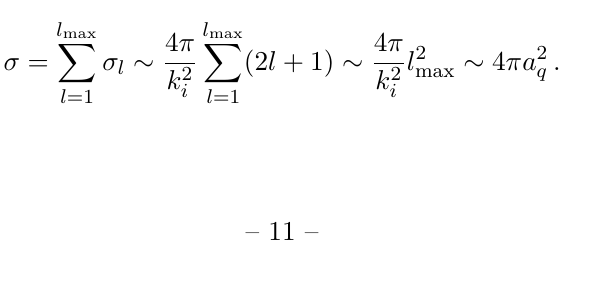
, the mean radius of X (cid:22) X